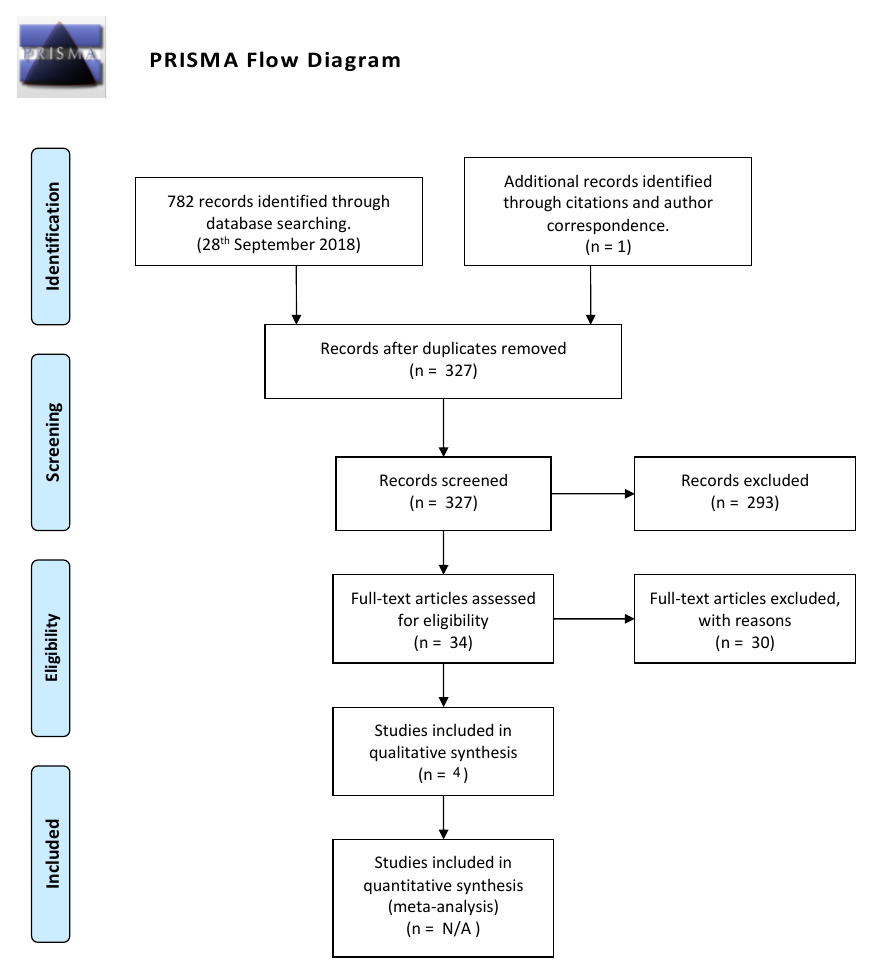
Figure 1. PRISMA flow diagram of study selection process.